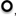
Different states of plasma membrane: central panel shows the membrane PD in different states as function of pHo and [K+]o (Ep reversal PD of the proton pump, EL reversal PD for the background/leak current, EK Nernst PD for K+, EH Nernst PD for H+ or OH-). The figure is based on Figure 1 (Beilby, 1990) with the I/V characteristics updated from later publications. Bottom panel: proton pump-dominated state at pHo of 4.5 ♦, 5.5 Δ, 6.5 □, and 7.5 • (Beilby, 1984). Ep is most negative at pHo 7–8 (shown as a dot on the “pump surface”) and tends toward EL at pH 4.5 (a point where the pump and background surfaces meet). Left panel: background state with 10 I/V runs summarized from nine cells exposed to DES (diethyl stilbestrol). These cells stabilized after 30 min DES exposure (shown by a point on the background surface). Four La3+-treated cells exposed to DES for 30 min, •, continued to change as shown by a single I/V run on La3+-treated cell, with DES exposure of I hr 15 min (Beilby, 1984). Top panel (Beilby, 1986): I/V characteristics of cells in K+ state, summary from seven cells in 5 mM K+ APW  10 mM K+ APW  (the two points on K+ surface) and 0.1 mM K+ APW • (here the K+ channels closed revealing the background state, see the arrow in central part of figure). Right panel (Beilby and Bisson, 1992): high pH state: pH 11.5 (dotted line), pH 10.5 – two I/V runs in fast succession shown by black shading, pH 10.5 + 2.5 mM Na2SO4 (dashed line), back to pH 10.5 (dash, two dots, dash line), pH 10.5 + 10 mM Na2SO4 (dash dot dash line), and finally back to pH 10.5 (dash, three dots, dash line). The I/V characteristics in this state can be quite variable. As NaOH (5–30 mM) was used to bring the APW to high pH, the effect of Na+ concentration increase was explored. Beilby and Bisson (1992) did not find a consistent effect, but high concentrations might affect the H+/OH- channel activation via ROS response, see text.